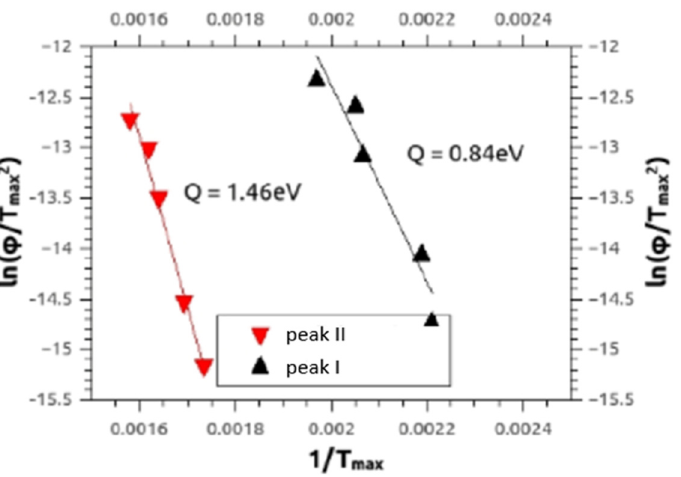
Figure 10. Typical Kissinger plots referring to Equation (5) for peak I and peak II measured by DSC, for HPT-processed Mg5Zn at 4 GPa for 10 rot. at 285 °C. The full lines represent the regressions to the experimental data, from which the activation enthalpies Q given were calculated.